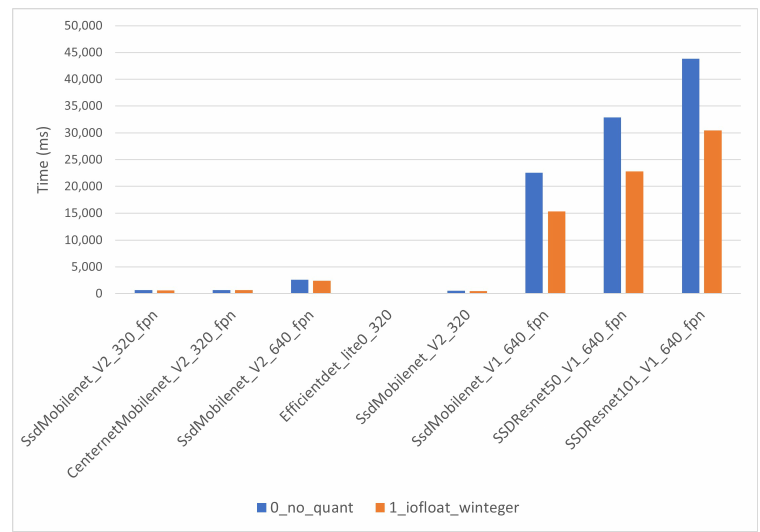
Figure 18. EdgeTPU inference time for CPU